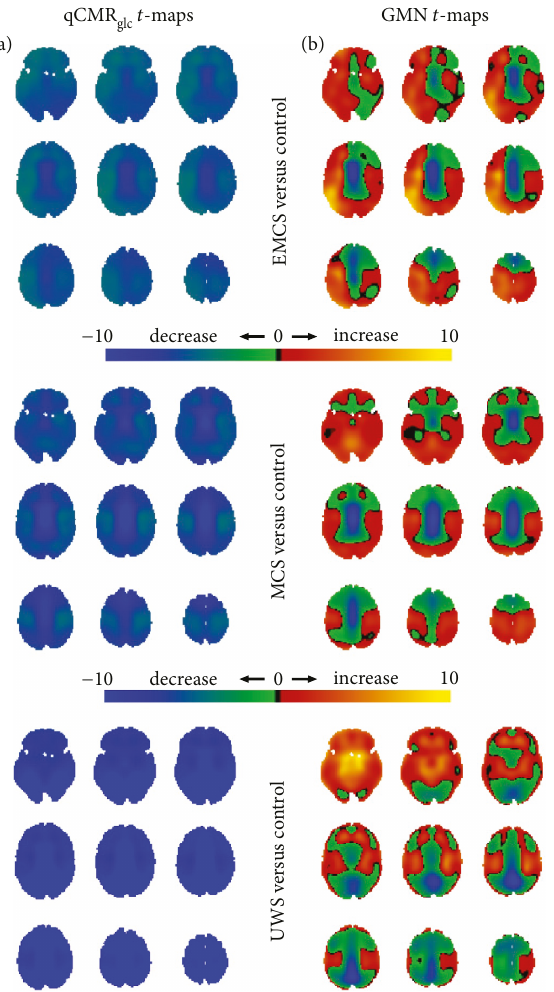
Figure 3: Spatial distributions of metabolic variations in patients with disorders of consciousness (i.e., UWS, MCS, and EMCS in Figure 2(c)) versus the control group (i.e., HAEC in Figure 2(a)), shown with respect to unthresholded Student ’ s t -maps using (a) qCMR GMN images. (a) For the UWS, MCS, and EMCS groups, the unthresholded t -maps with qCMR decreases in patients with disorders of consciousness. (b) But the unthresholded t -maps with GMN demonstrated the presence of regionally bidirectional metabolic changes in disorders of consciousness. Based on validation of qCMR without GMN the global decreases corresponded to about 0.15 μ mol/g/min (UWS < MCS ≈ EMCS) and with GMN the global changes were diminished to put overemphasis on the regional di ff erences. See Figure S3 for thresholded maps (Table